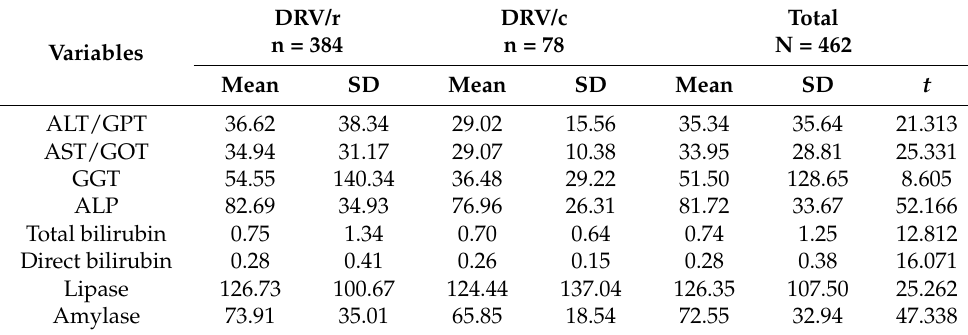
Table 9. Descriptive statistics of liver function parameters ( p <